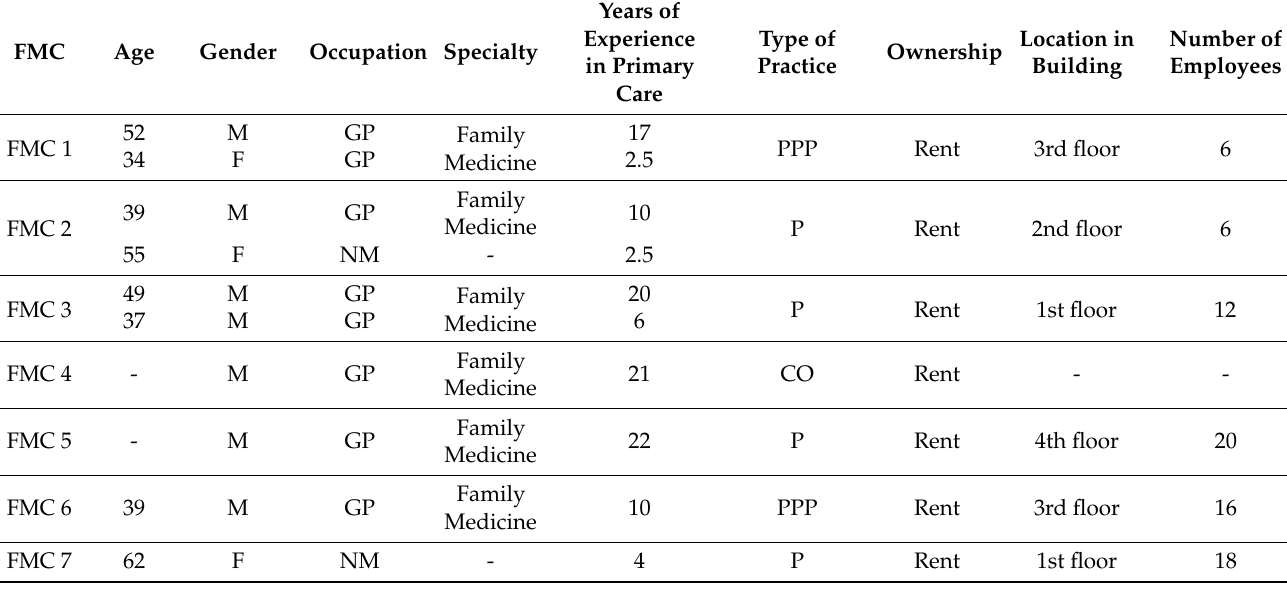
Table 2. Sociodemographic characteristics of participants and FMC